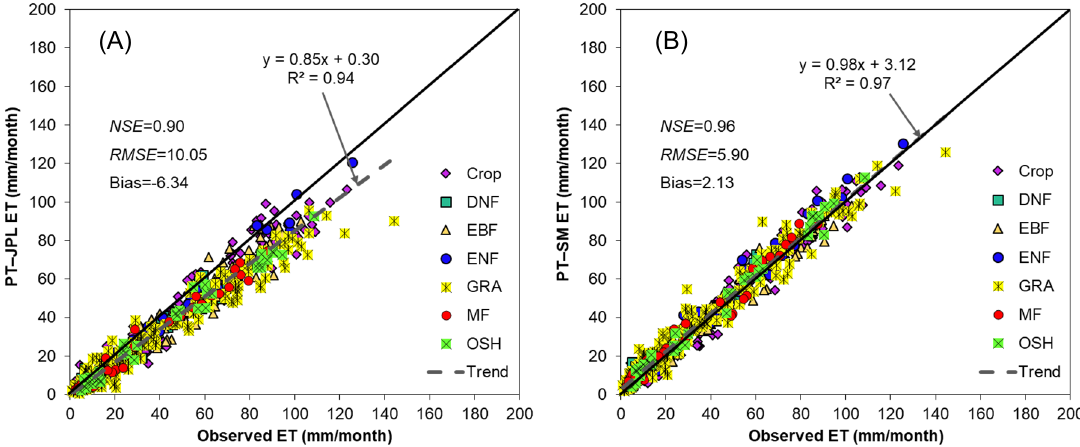
Figure 7. Observed evapotranspiration (ET) at eddy covariance sites vs. ( A ) PT–JPL ET and ( B ) PT–SM ET. The solid line is the 1:1 line and the short dashed line is the trend line for ET series of all land cover types of the 17 EC sites.